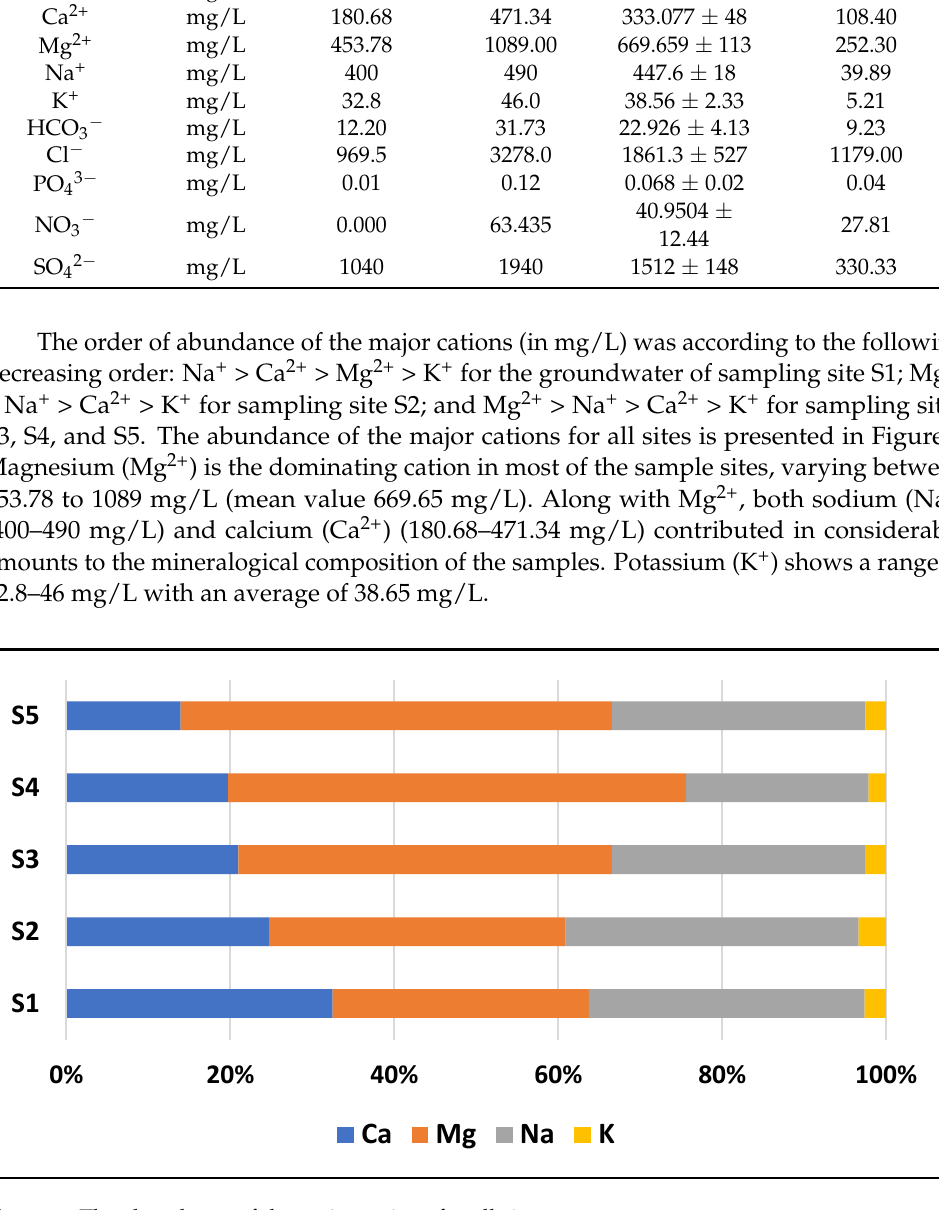
Figure 2. The abundance of the major cations for all sites .